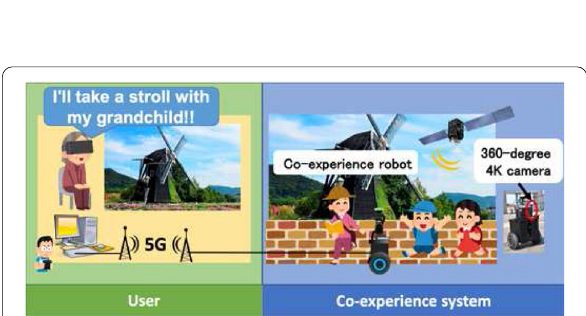
Fig. 2 Conceptual diagrams of the co-experience system. The user can share an experience (360-degree 4K video) of the robot remotely through the 5G